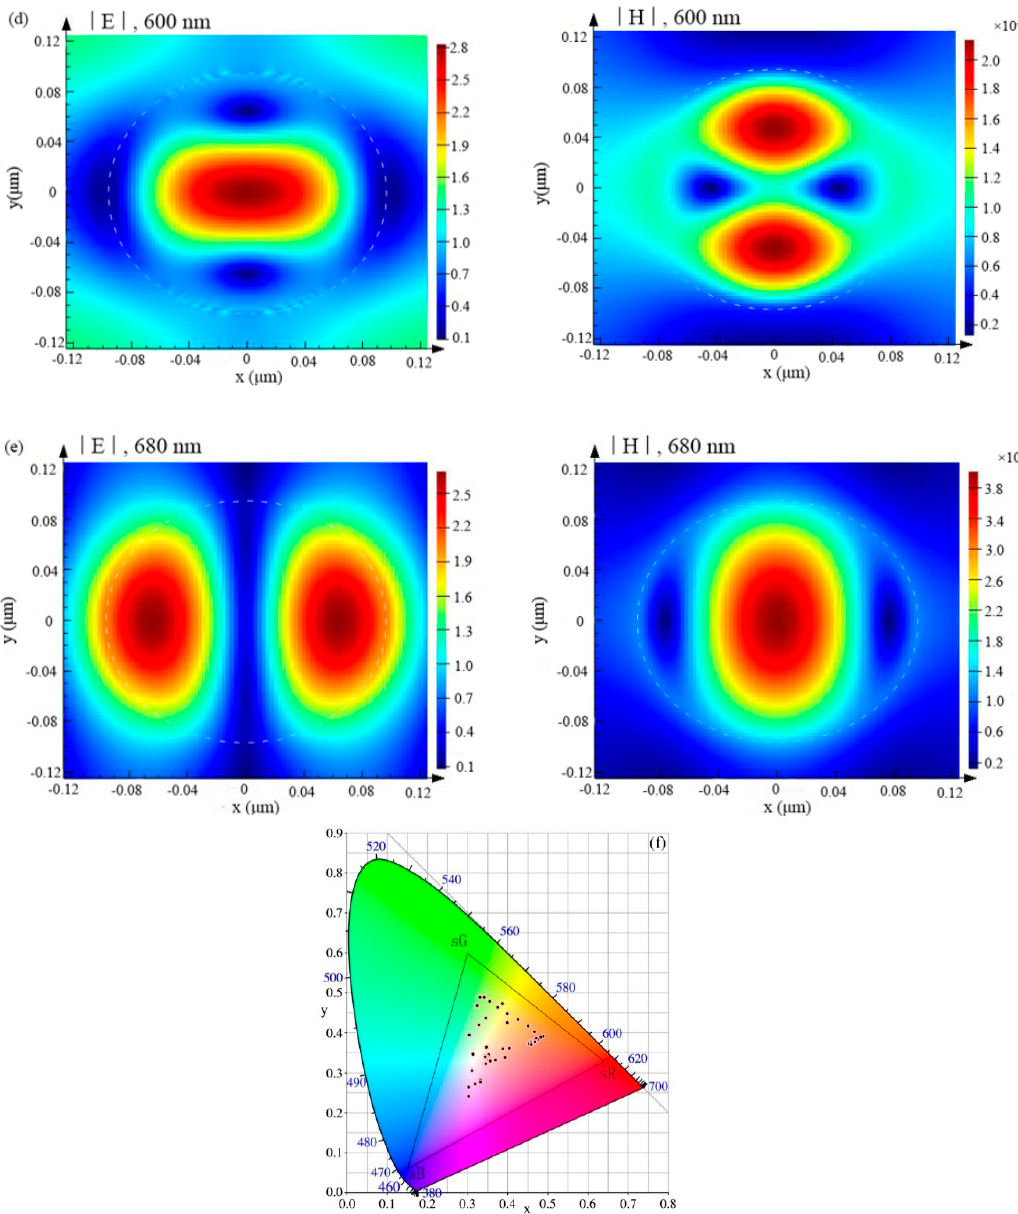
Figure 2. The reflection spectra and the field distribution. ( a ) The reflection spectra with D = 190 nm and p = 290 nm. ( b ) The reflection spectra with D = 115 nm and p = 290 nm. ( c ) The reflection spectra with D = 100 nm and p = 190 nm. ( d ) The electric dipole resonances with D = 190 nm, p = 290 nm and λ = 600 nm. ( e ) The magnetic dipole resonances with D = 190 nm, p = 290 nm and λ = 680 nm. ( f ) The CIE 1931chromaticity diagram obtained from the reflection spectra with different D and p . D varies from 30 nm to 200 nm. p takes the value of 140 nm, 190 nm and 290 nm, respectively.